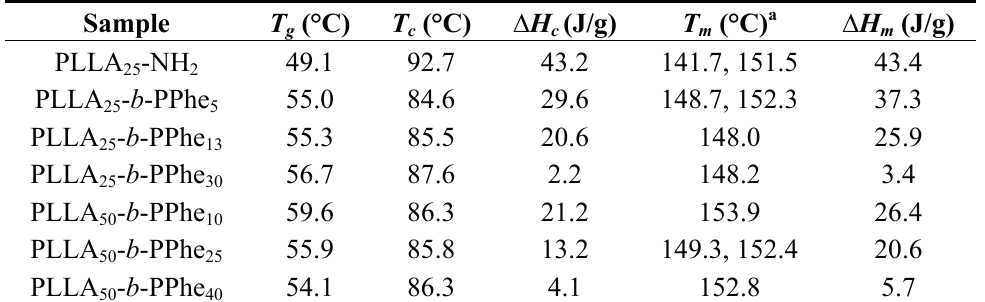
Table 3. Calorimetric data (20 °C/min) of hybrid copolymers obtained in the heating run of a previously quenched